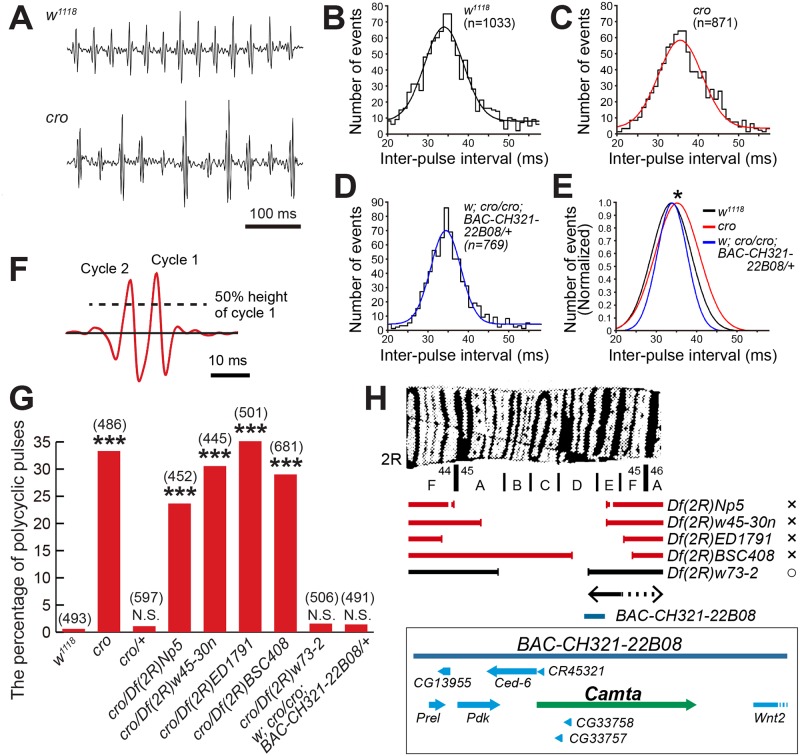
Genetic complementation tests identify the Camta-encoding region to be responsible for the cro mutant song phenotype.(A) Typical examples of pulse songs from males of the control w1118 (upper trace) and cro mutant (lower trace). (B-E) The interpulse interval (IPI) is susceptible to the cro mutation. (B-D) Distribution of IPIs in the control w1118 (B) and cro homozygote without (C) or with (D) the genomic rescue fragment BAC-CH321-22B08. The Gaussian fit to the IPI distribution is drawn on each histogram, and in (E) three Gaussian curves are superimposed on the same panel to facilitate comparisons. The statistical differences were evaluated by one-way ANOVA followed by Bonferroni’s multiple comparisons; *: P<0.05. (F) Criteria used to classify the recorded pulses as monocyclic or polycyclic. The peak height of the song pulse (the peak) is measured from the baseline and the 50% of this value is chosen as the slice level. When any deflections other than the primary peak exceed the slice level, the pulse is judged to be polycyclic. When the peak is the only deflection that exceeds the slice level, the pulse is judged to be monocyclic. (G) The incidence of polycyclic pulses compared among the genotypes indicated. The number of song pulses used to calculate the proportion of polycyclic pulses is indicated in parentheses above the bars. The proportion of polycyclic pulses is shown. The statistical significance between the control and a test group is evaluated by the Fisher’s exact probability test. ***: P<0.001, NS: not significant. (H) A diagrammatic representation of the genomic regions (cytology is at the top) that are deleted in deficiency chromosomes. The region covered by BAC-CH312-22B08 and the genes and their transcriptional directions are indicated by pointed bars in an expanded scale.